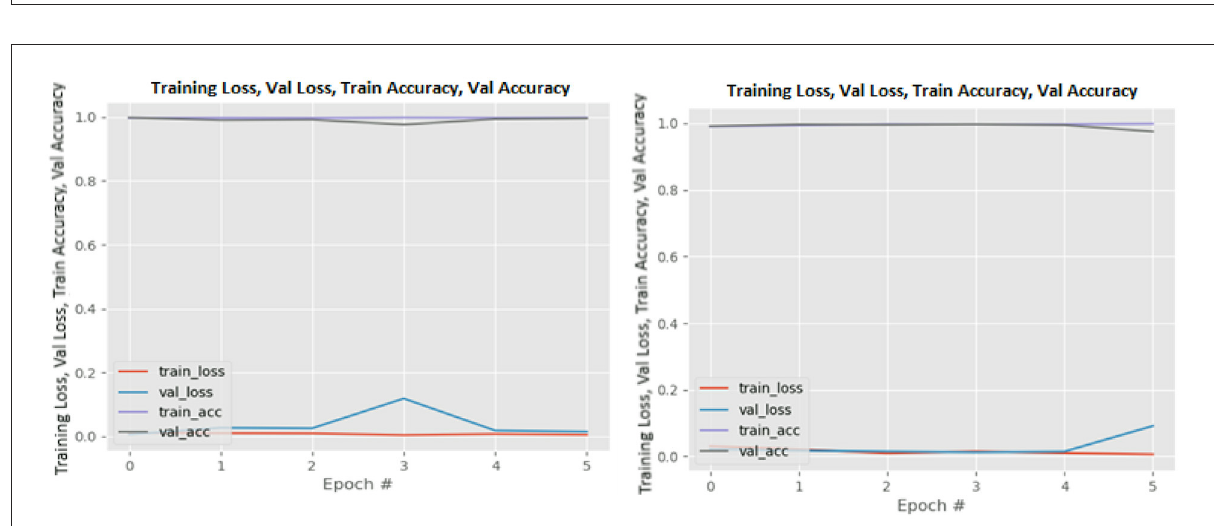
FIGURE10 DenseNet201 without data augmentation (left image) and with data augmentation (right